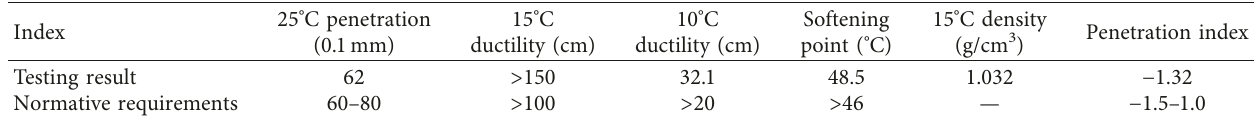
Table 3: The main performance parameters of asphalt.